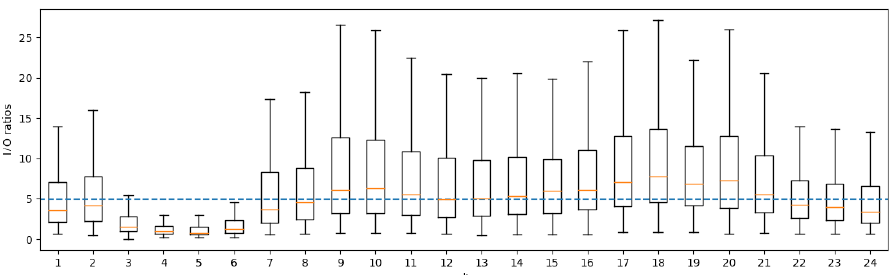
Figure 5. Hourly distributions of indoor / outdoor PM 2 . 5 ratios for subway platforms issued from in-platform measurements of the SQUALES network and outdoor measurements of the AIRPARIF network. The blue line is the median I / O ratio.